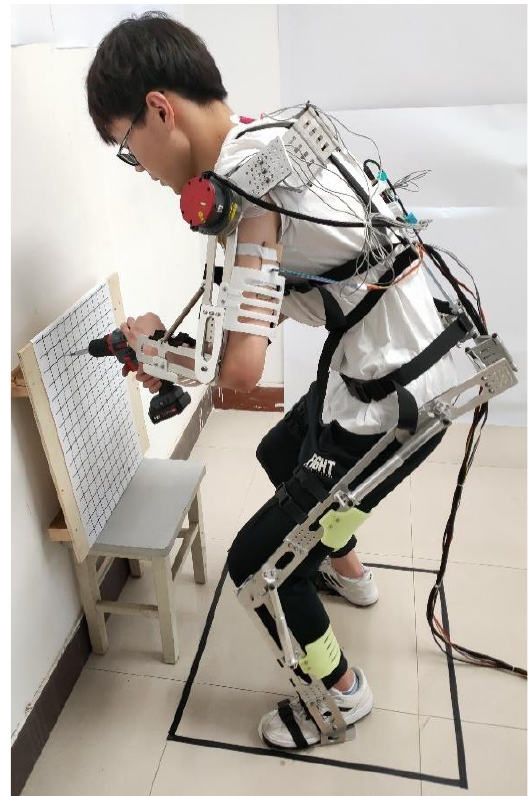
Figure 2. Experimental setup: Participant with wearable robot is using a cordless screwdriver to install screws in the requested location. Working height and distance to the set-up were individually adjusted to ensure a knee angle of ~45° — the installation and removal position.